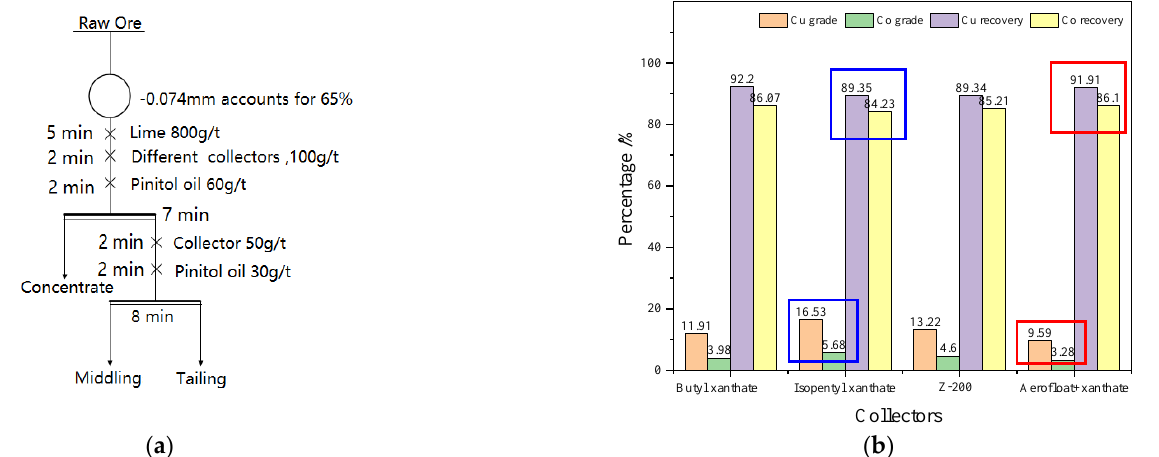
Figure 7. Effect of collector type on the recovery of sulfide aggregates. ( a ) The flow chart for flotation experiments ( b ) The result for flotation experiments.